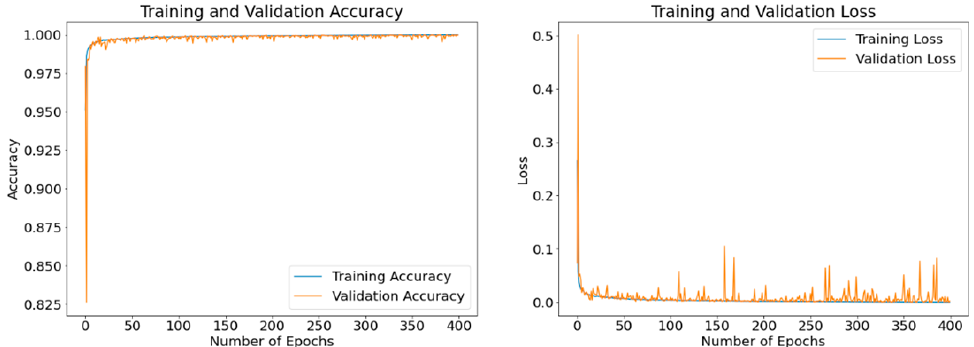
Figure 13. Accuracy and loss curves generated by RMSProp optimizer after model training (blue) and validation (orange). A batch size of 8 and 400 epochs are utilized.